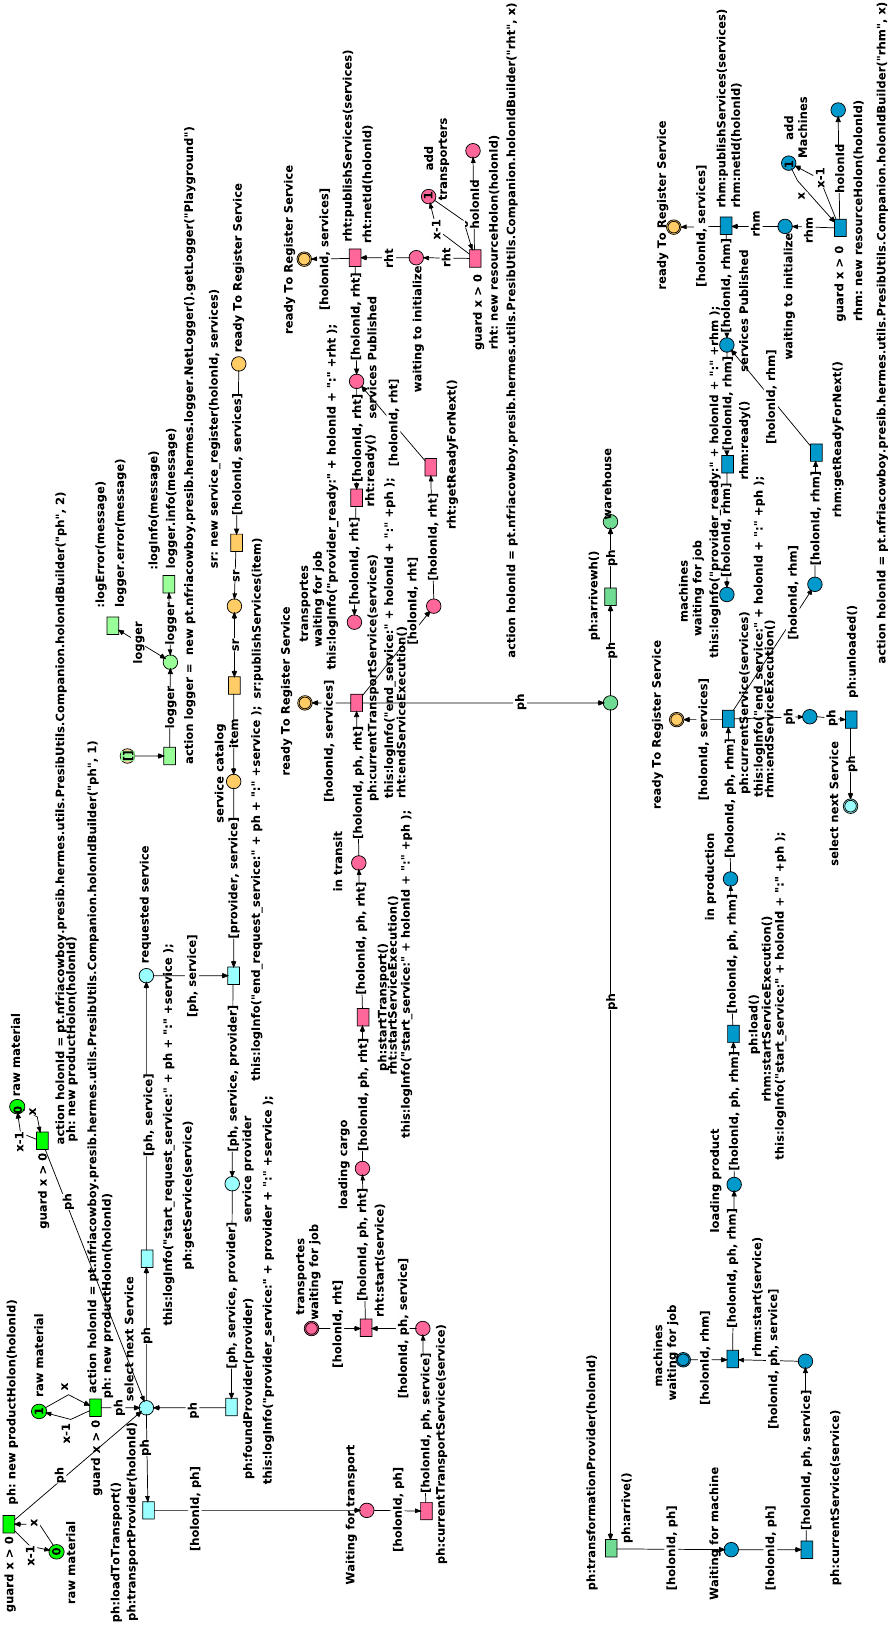
Figure 14. Playground Net